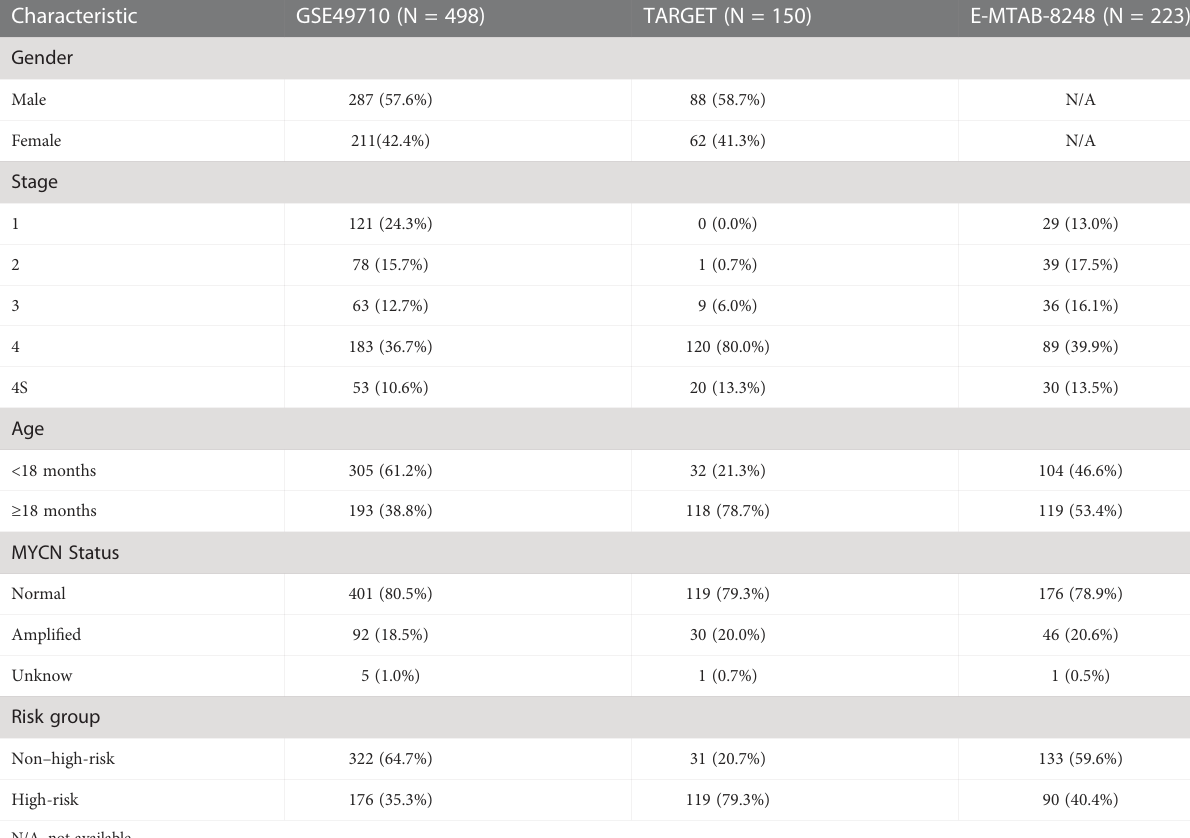
TABLE 1 Clinical baseline characteristics of three datasets in present